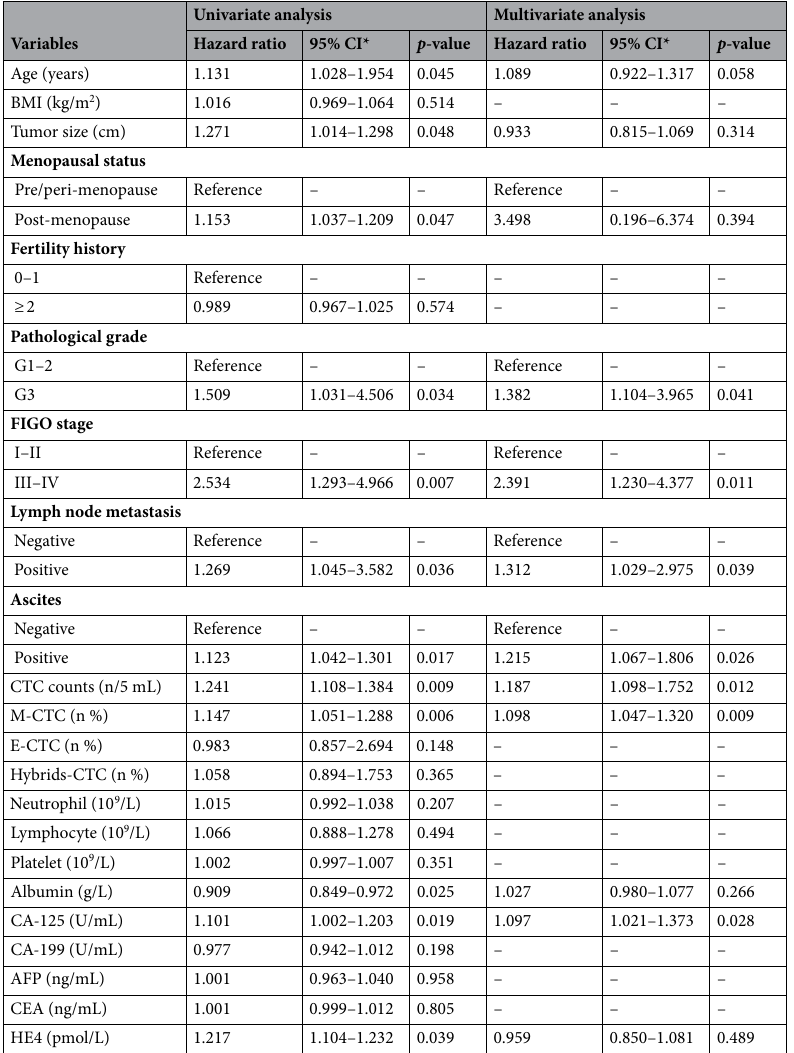
Table 3. Clinicopathological features selection using the univariable and multivariate Cox logistic regression model among the training group. BMI Body Mass Index, FIGO the International Federation of